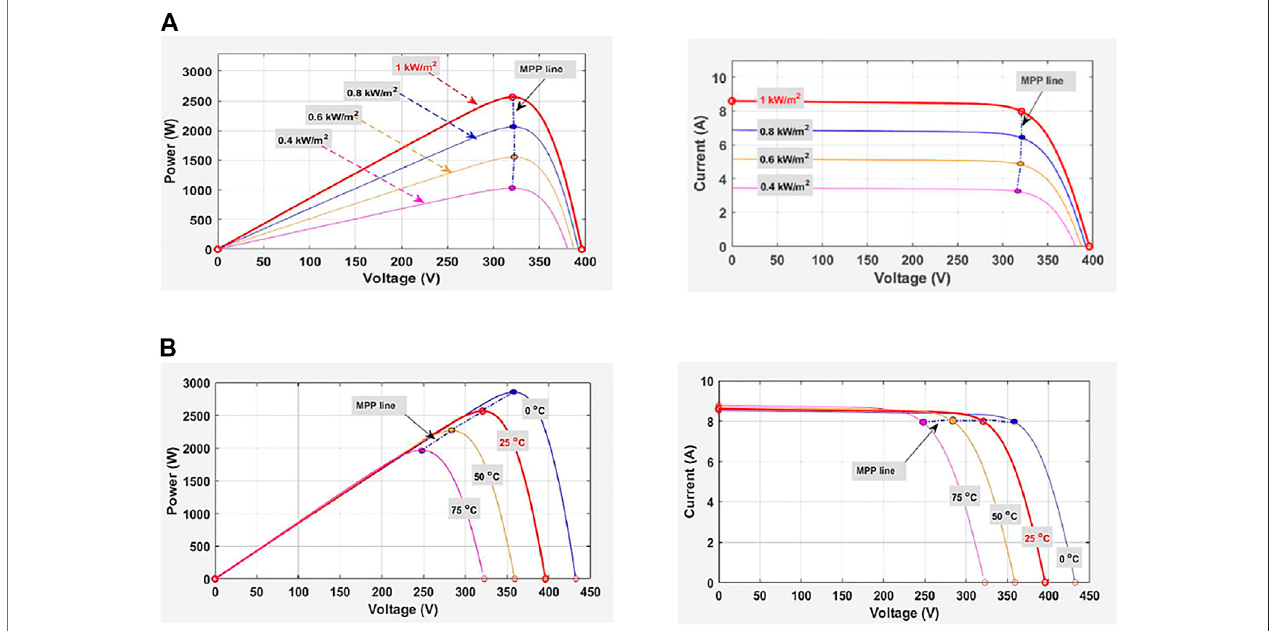
FIGURE 3 | P-V and I-V characteristics for PV module Kyocera solar KD320GX-LPB under (A) for varying irradiance (W/m 2 ) and (B) for varying temperature ( ° C).